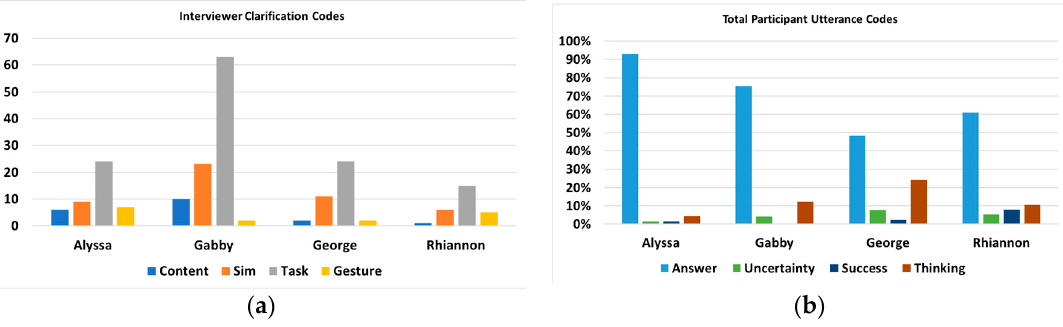
Figure 9. Total frequencies of interaction codes: ( a ) interviewer clarification; ( b ) student utterances.